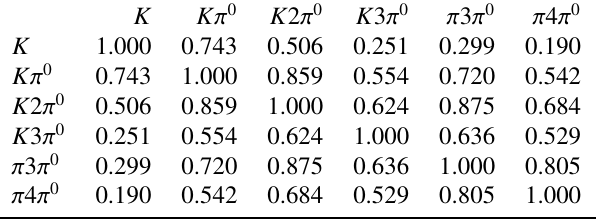
Table 3. Systematic correlation matrix for the branching fractions of the signal modes (preliminary).